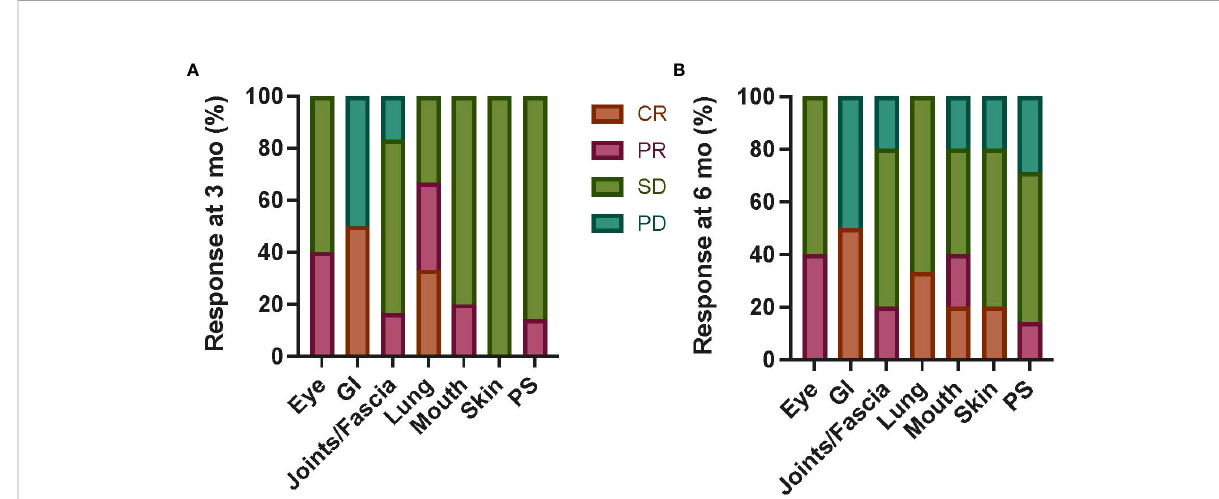
FIGURE 2 Chronic GVHD organ-speci fi c responses following autologous MSC infusion. Organ-speci fi c responses were assessed at 3 months (A) and 6 months (B) from fi rst MSC infusion in six patients with primary indication of chronic GVHD regardless of dose level. CR was seen in a subset of patients with GI and lung involvement at both timepoints; otherwise, most patients had PR or SD in all organs. The proportion of patients with PD was highest in the GI system (50% at both 3 and 6 months), with a smaller proportion in joints/fascia, mouth (3 months only), and PS (3 months only) systems. Mo, months; GI, gastrointestinal; PS, performance score; CR, complete response; PR, partial response; SD, stable disease; PD, progressive disease; GVHD, graft-versus-host disease; MSC, mesenchymal stromal